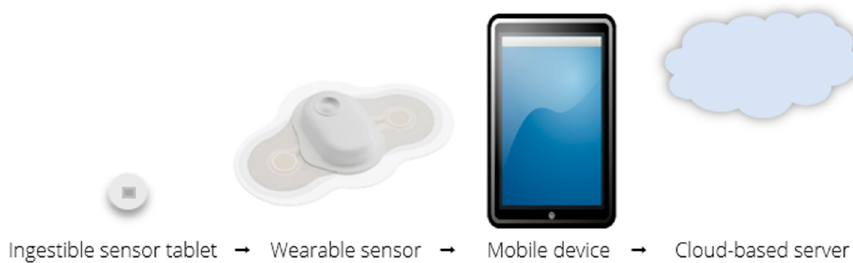
Figure 1. Digital medicine system data flow.